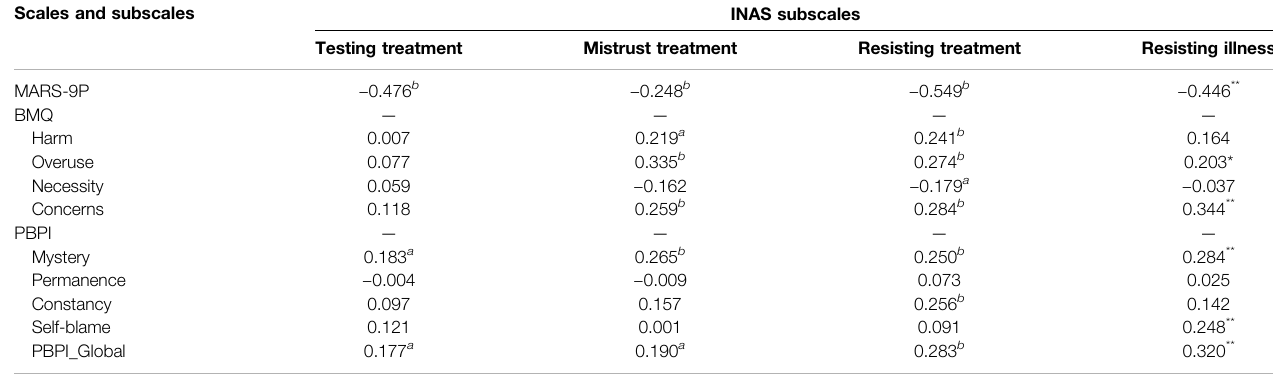
TABLE 3 | Convergent and discriminant validity of INAS: Person correlation coef fi cients between subscales of the MARS-9P; subscales of BMQ; and PBPI global and